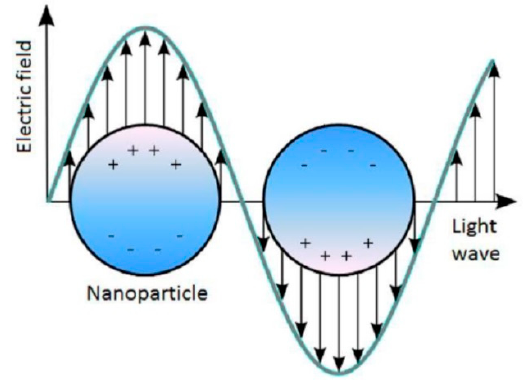
Figure 1. Metal NP external electric field interaction [17].